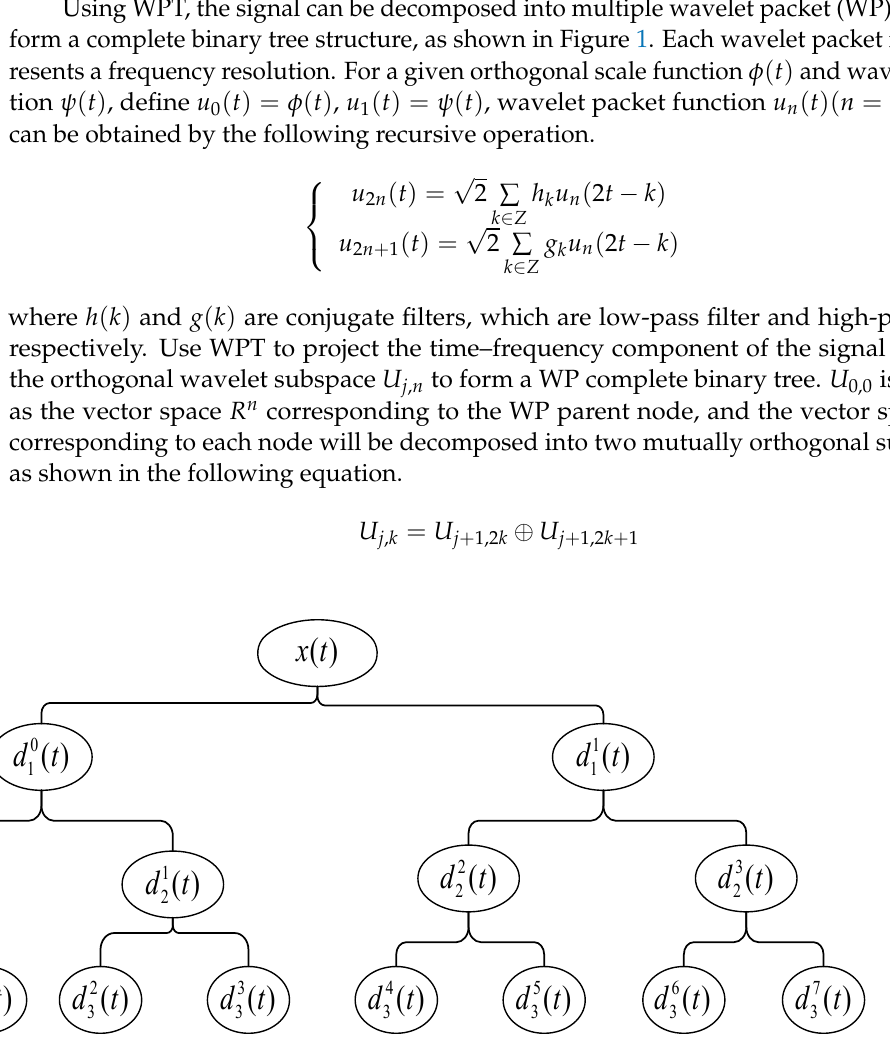
Figure 1. Wavelet packet decomposition (WPT) decomposition process.